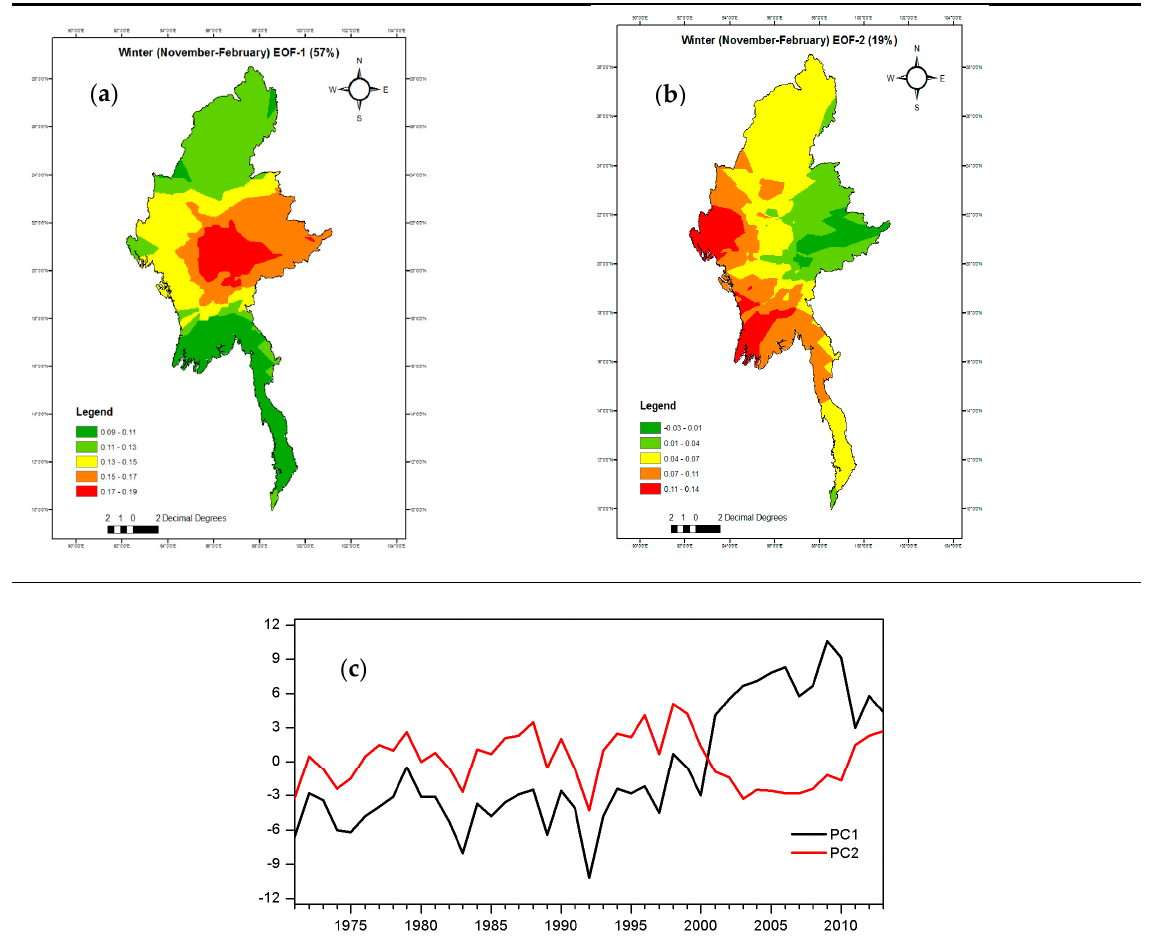
Figure 10. Winter (November–February) air temperatures ( a ), the first mode of EOF ( b ), and the second mode of EOF ( c ) with respect to the corresponding air temperature of principal components PC1 and PC2.